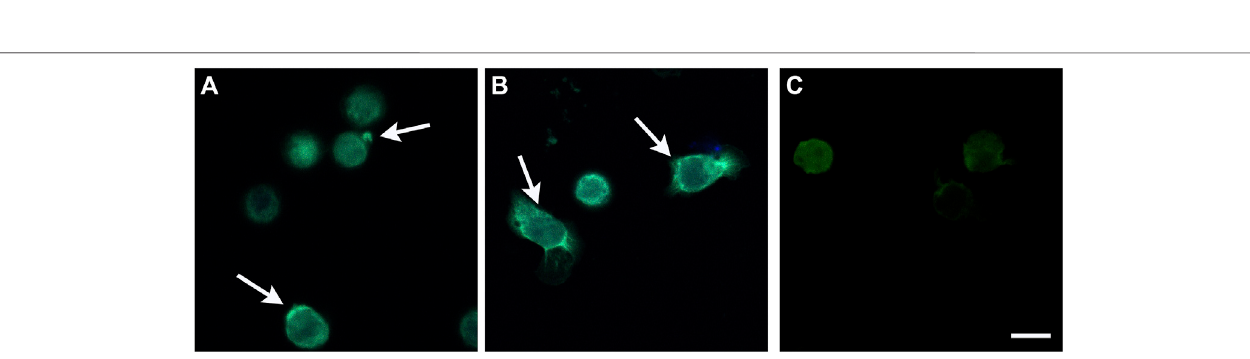
FIGURE 2 | Lack of Antibiotic Activity by Alphataxin. D-Ampicillin-sensitive E. coli DH5-Alpha, calibrated using McFarland Turbidity Standard 0.05 for < 300 × 10 6 CFU,wasspread onMueller-Hintonagarplates.Filterdisks(6 mmdiameter)wereplacedontheagarandtoeach diskwasapplied D-ampicillin(10 μ l)orAlphataxin (10 μ l) in 10-fold serial dilutions, counterclockwise, beginning with 50 mM concentration. After incubation for 16 h at 37 ° C, plates were examined for zones of inhibition (clear agar). (A) The diameters of the zones of inhibition by D-ampicillin at concentrations of 50 mM (12 o ’ clock), 5 mM (10 o ’ clock), and 0.05 mM (8 o ’ clock) were 3.8, 3.0, and 1.4 cm, respectively. (B) The diameters of the zones of inhibition by Alphataxin at 50 mM (at 12 o ’ clock) and 5 mM (10 o ’ clock) were 2.8 and 1.5 cm, respectively. Images are representative of two repeated experiments.